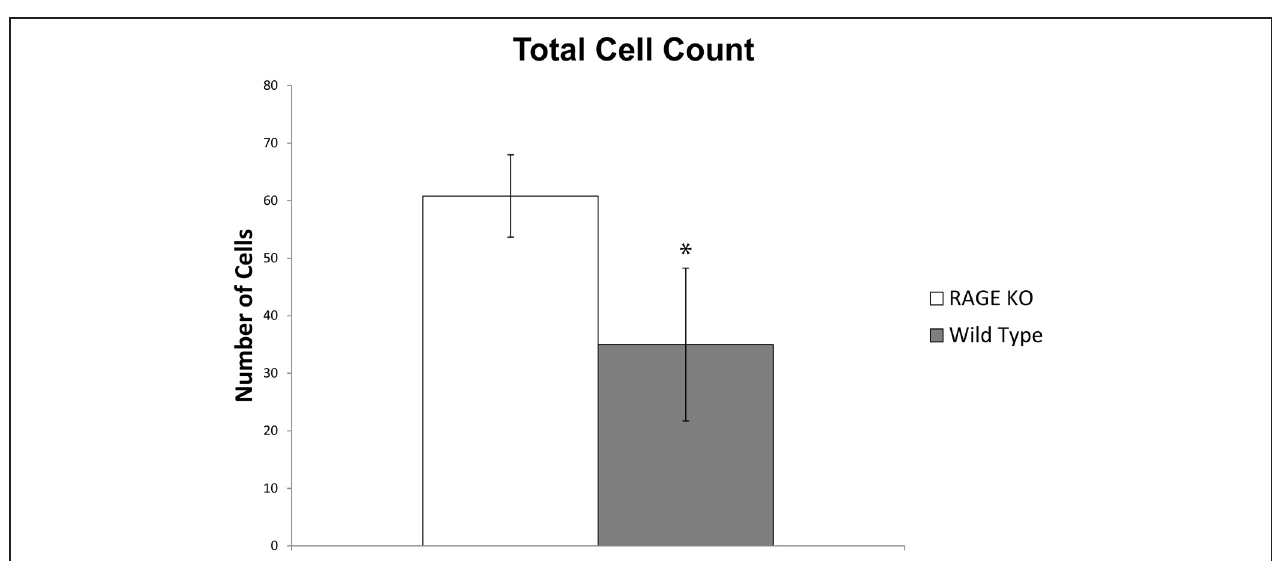
FIGURE 4 | RAGE KO samples ( n = 5), when compared to wild type samples ( n = 6), demonstrated a significantly higher number of total chondrocytes counted in a defined 200 × 900 pixel area of articular cartilage immediately distal to the tibial plateau at 400 × magnification ( ∗ p < 0 .